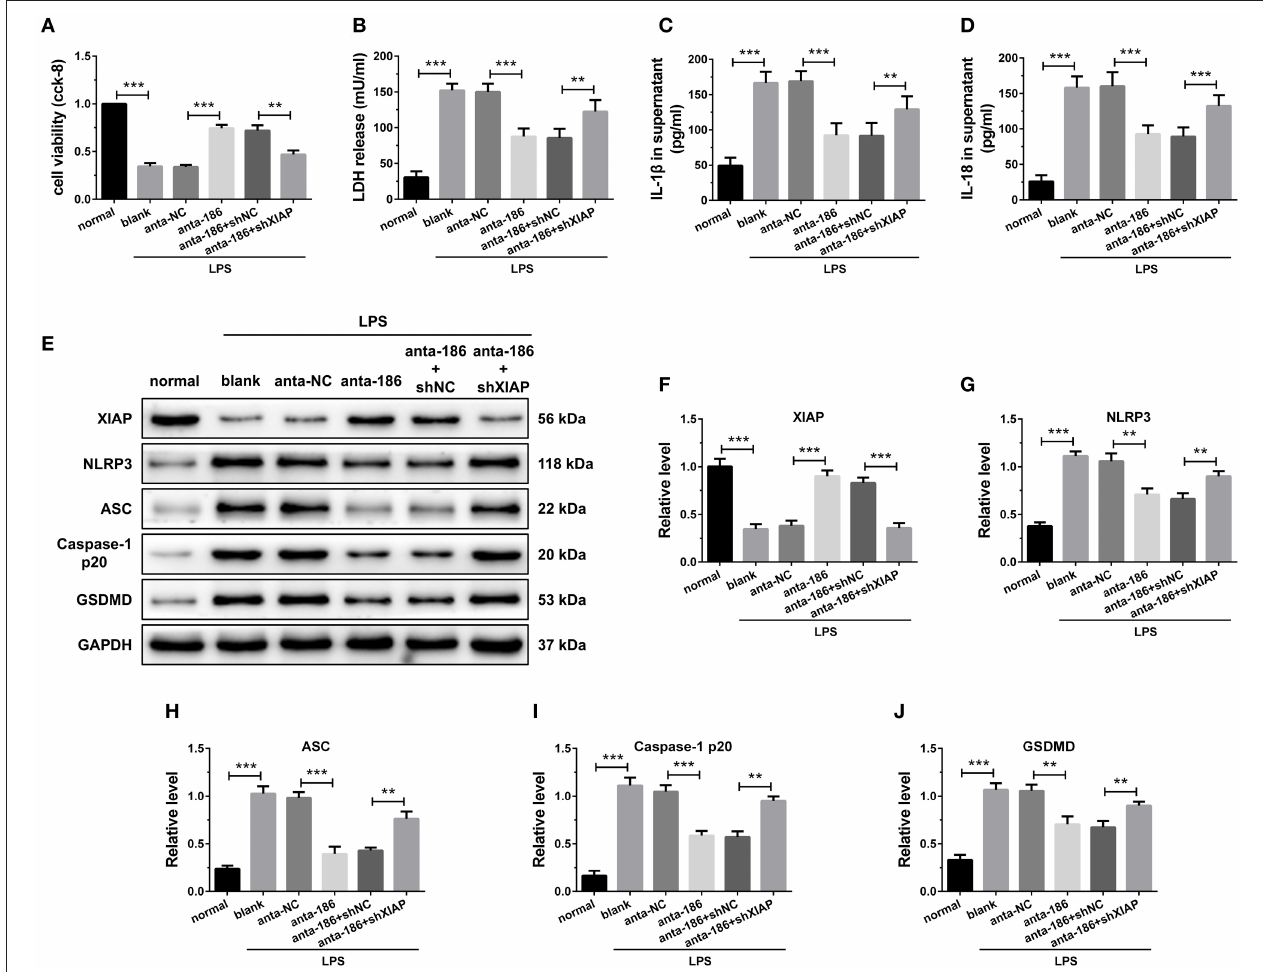
FIGURE 7 | Inhibition of miR-186-5p suppressed cardiomyocyte pyroptosis through regulation of XIAP. (A) A CCK-8 assay used to gauge H9C2 cardiomyocyte viability ( n = 3). Supernatant (B) LDH, (C) IL-1 β , and (D) IL-18 levels were measured via ELISA ( n = 6). (E-J) Western blotting was used to quantify cardiomyocyte XIAP, NLRP3, ASC, caspase-1 p20, and GSDMD protein levels with GAPDH as a loading control ( n = 3). Data are mean ± SEM from three or more independent experiments. * P < 0.05, ** P < 0.01, *** P <